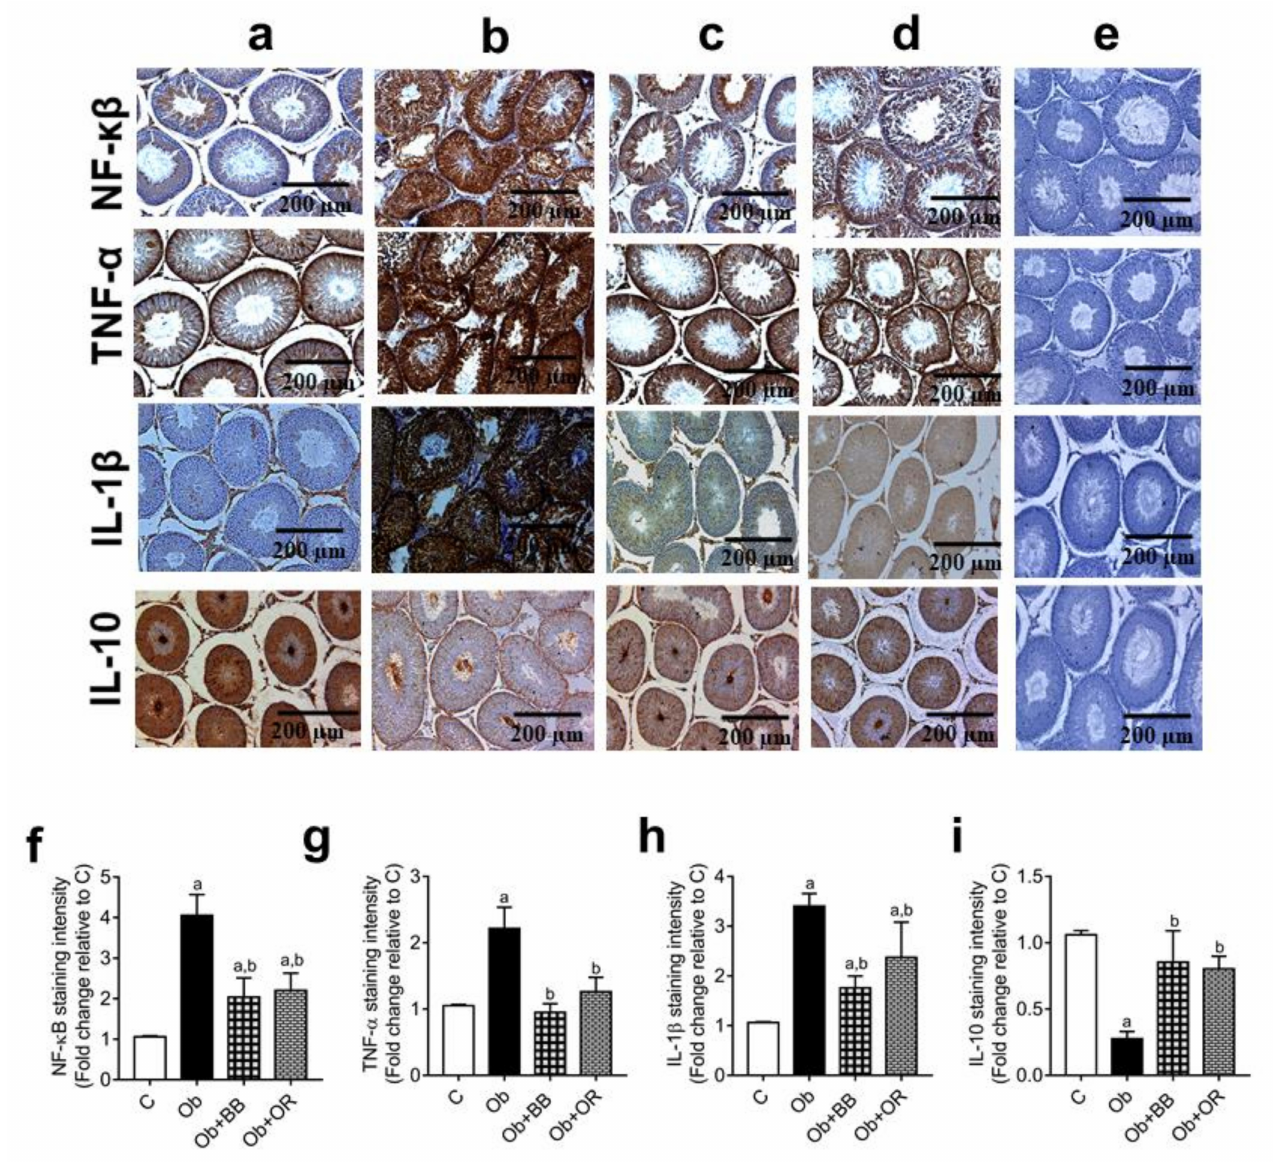
Figure 4. Effects of bee bread on immunoexpression of NF- κ B, TNF- α , IL-1 β and IL-10 proteins in the testes of obese rats. For each protein, C, Ob, Ob + BB and Ob + OR groups are represented by ( a – d ), respectively, while ( e ) represents the negative control (PBS). Staining using immunohistochemistry protocol showed seminiferous tubules with increased expressions of NF- κ B, TNF- α and IL-1 β , and decreased expression of IL-10 in Ob group, compared to C, Ob + BB and Ob + OR groups. Quantitative data are shown in ( f ) NF- κ B, ( g ) TNF- α , ( h ) IL-1 β and ( i ) IL-10. Values are mean ± SD, n = 6. a p < 0.05 vs. C, b p < 0.05 vs. Ob (one-way ANOVA followed by Tukey’s post-hoc